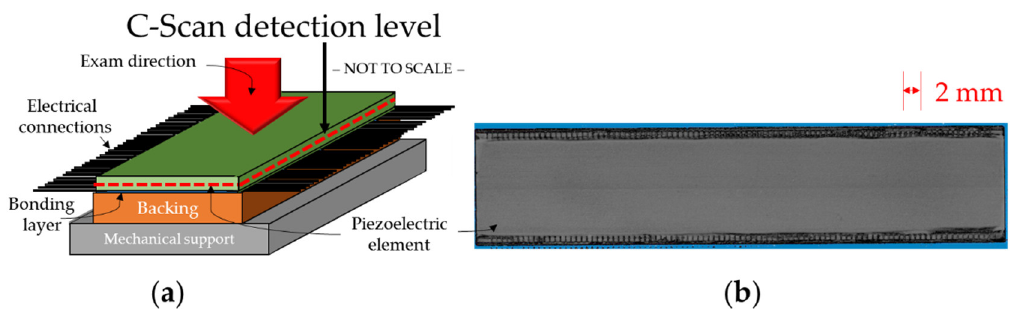
Figure 6. The C-scan by means of SAM. ( a ) The exam direction versus the ultrasound probe; ( b ) the image of the slice in the bulk of the piezoelectric element shows no defects.